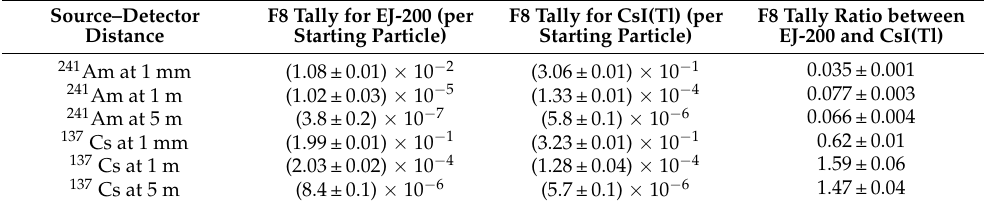
Table 4. Comparison of the MC simulation data (F8 tally) for the EJ-200 and CsI(Tl) detectors considering point sources of 241 Am and 137 Cs at different source–detector